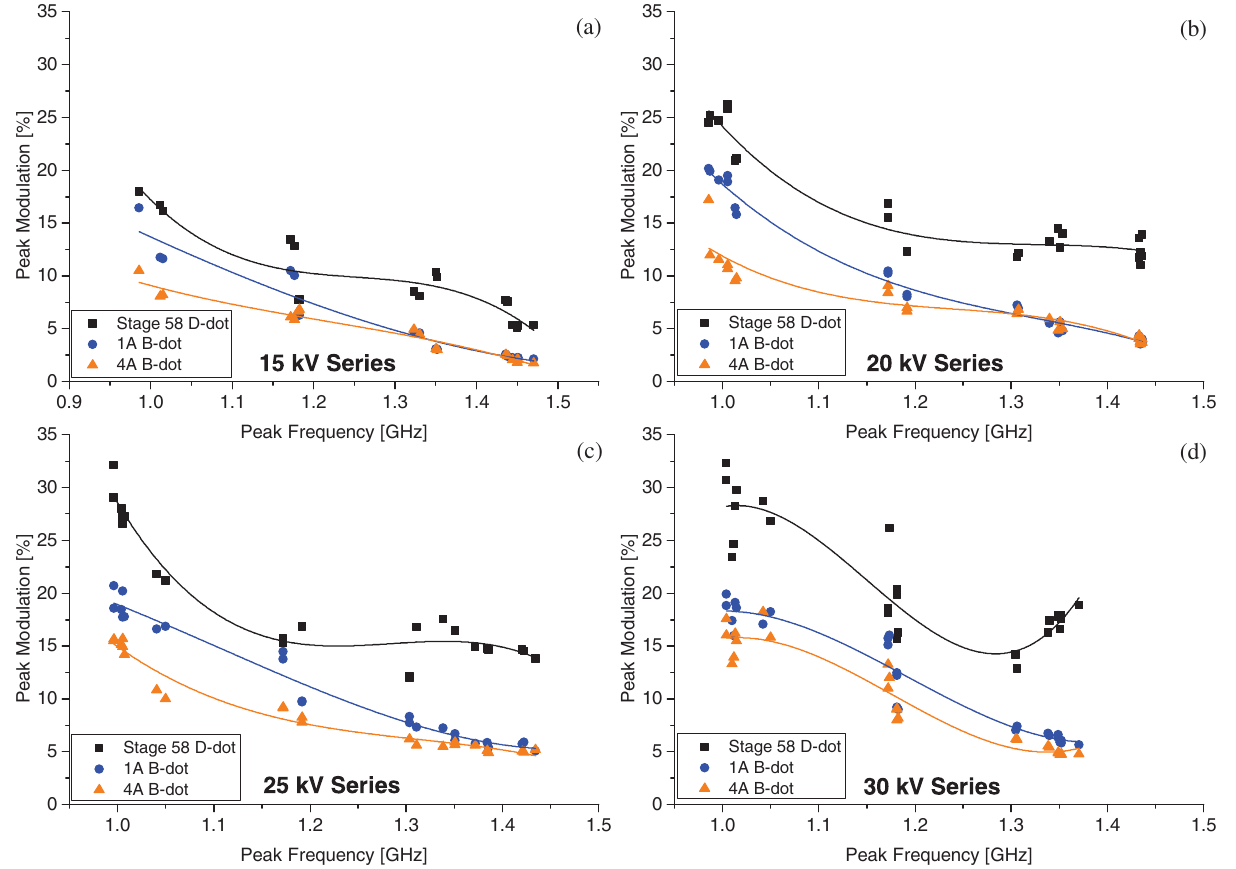
FIG. 11. Peak modulation as a function of peak frequency of the Stage 58 D-dot, 1AB-dot, and 4A B-dot signals as a function of shot number for the 15 kV (a), 20 kV (b), 25 kV (c), and 30 kV (d) Marx charge experimental series. Peak frequency values are from the Stage 58 D-dot FFT of each shot.